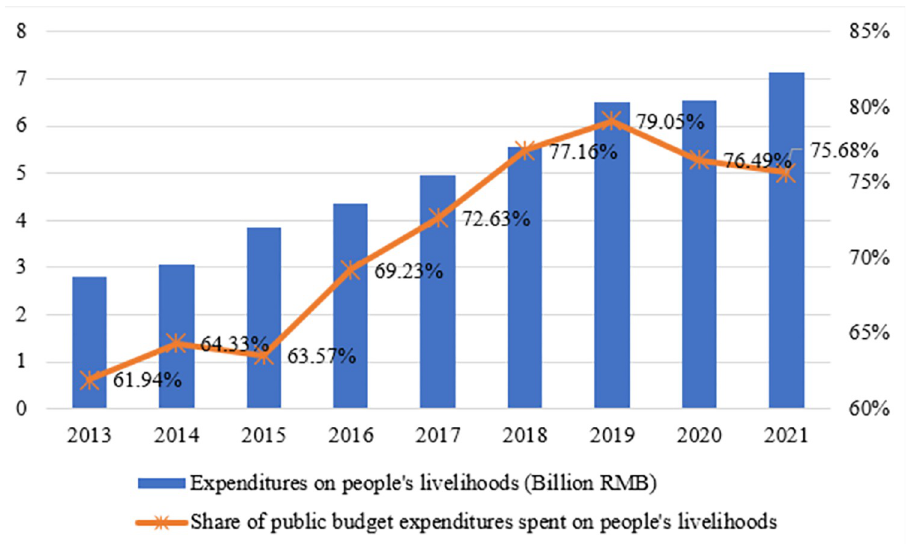
Fig 8. Changes in the expenditures on people’s livelihood and the share in public budget expenditures in Fenghua District (County), 2013–2021.